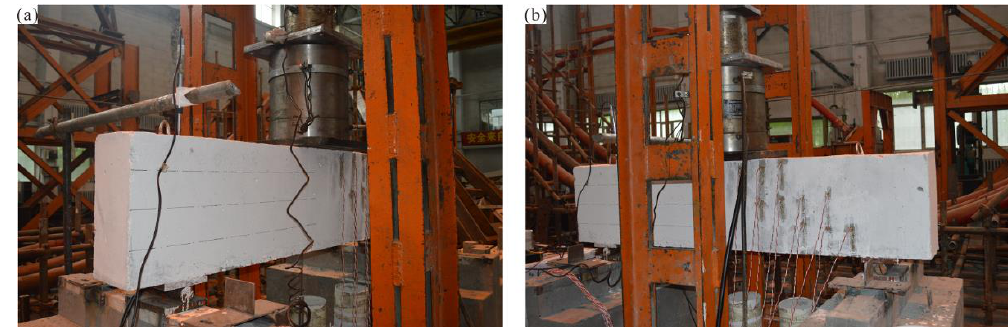
Figure 4. Test set-up on RC-control beam.